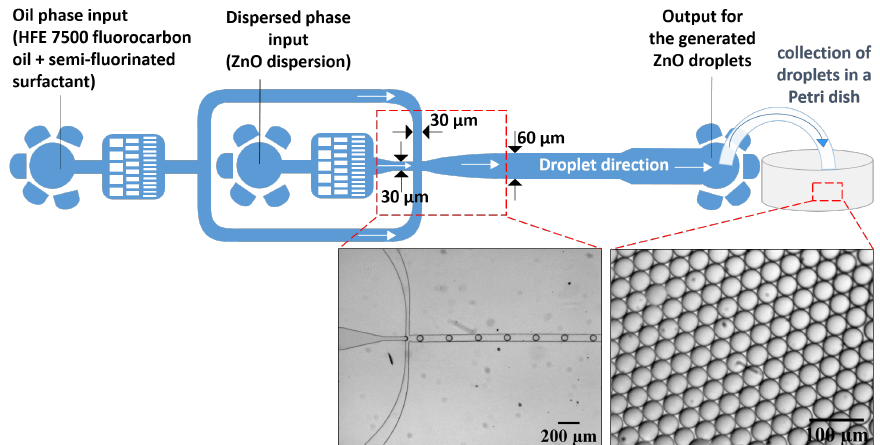
Figure 1. ( top ) Schematic illustration of the flow-focusing microfluidics design for zinc oxide droplet formation. ( bottom ) Optical micrographs of real-time generation of stable and monodisperse zinc oxide